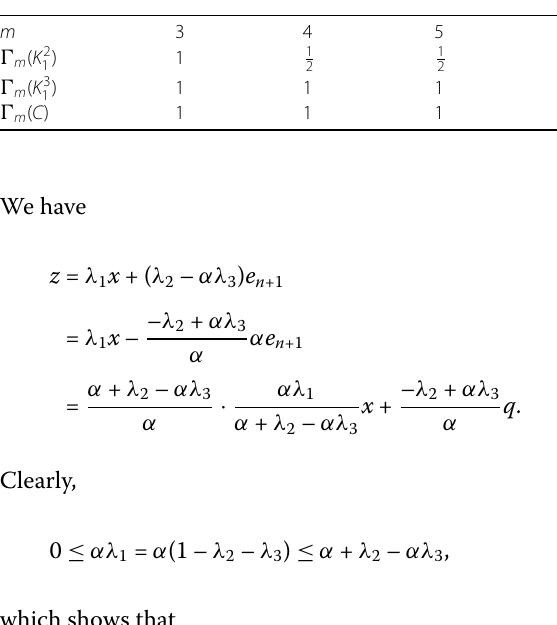
) (cf. [9, p. 2559]) and consequences of 1